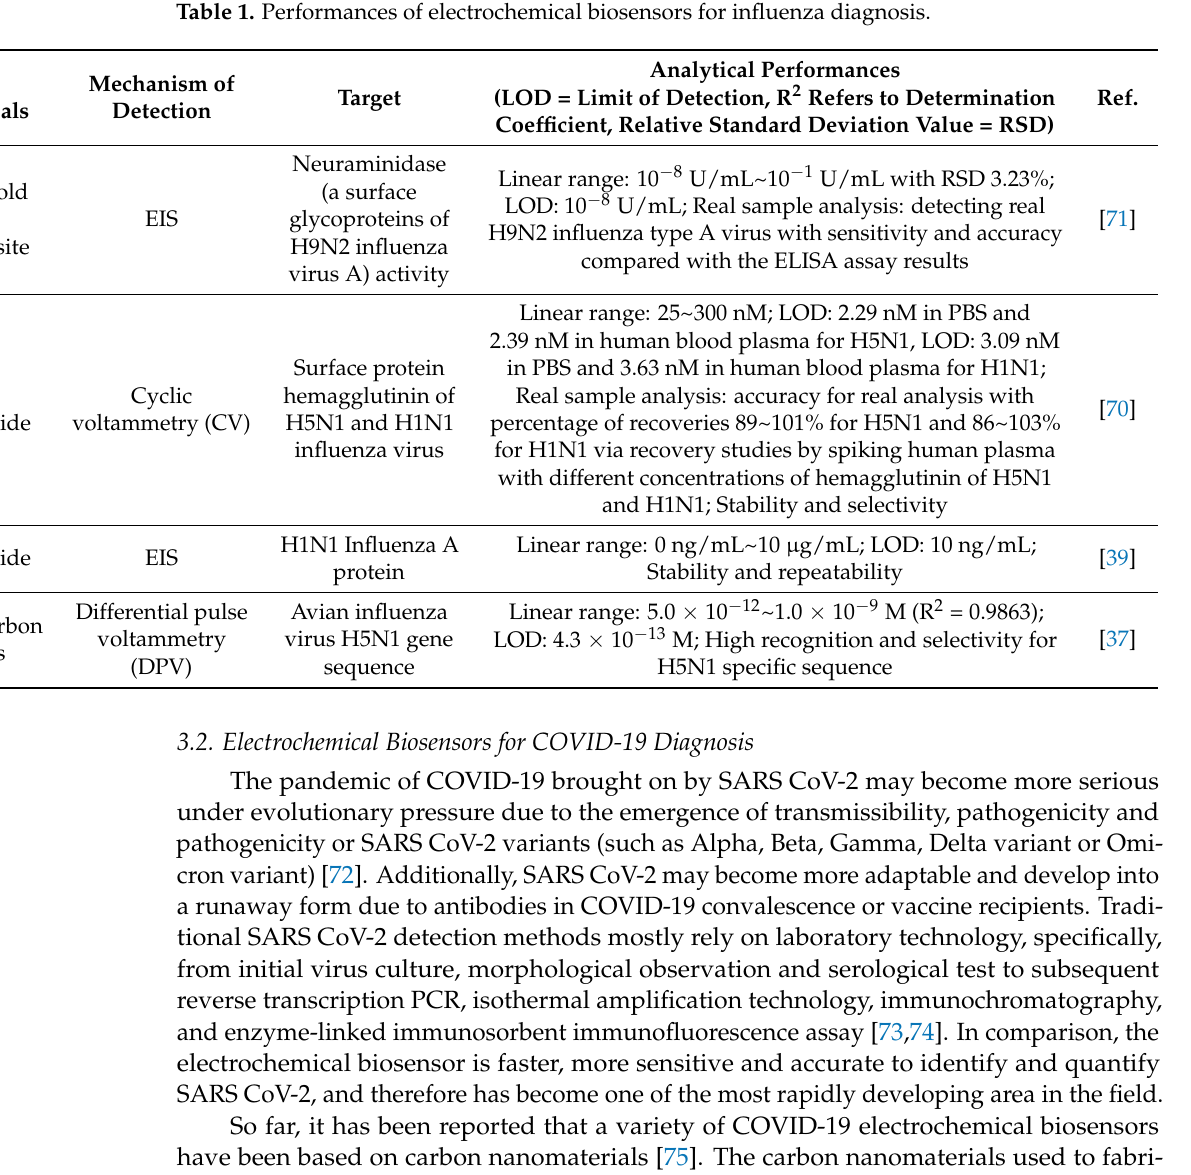
Table 1. Performances of electrochemical biosensors for influenza